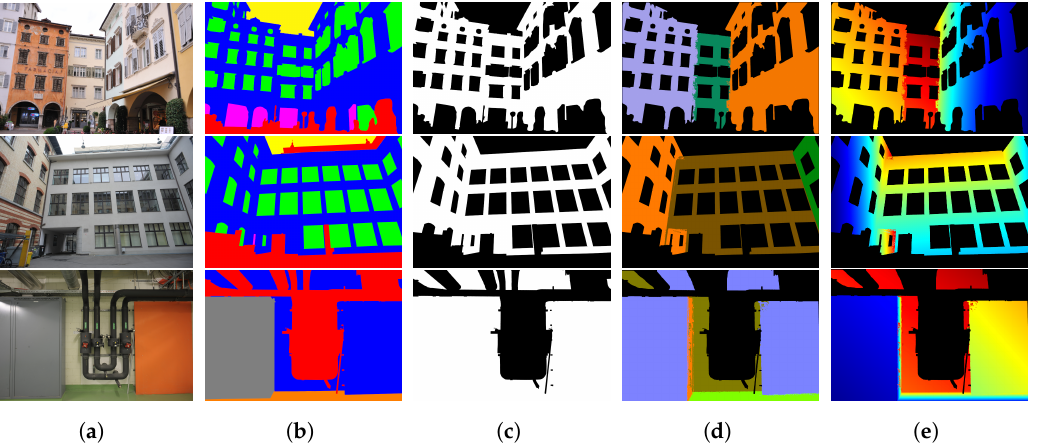
Figure 3. Plane prior estimation: input image ( a ); respective labels ( b ) for semantic classes: sky (yellow), wall (blue), window (green), door (purple), other (red); binary mask for planar classes ( c ); the estimated normal prior map for the RANSAC planes detected in 3D ( d ) and their respective depth priors in color scale ( e ) with blue being the closest and red the